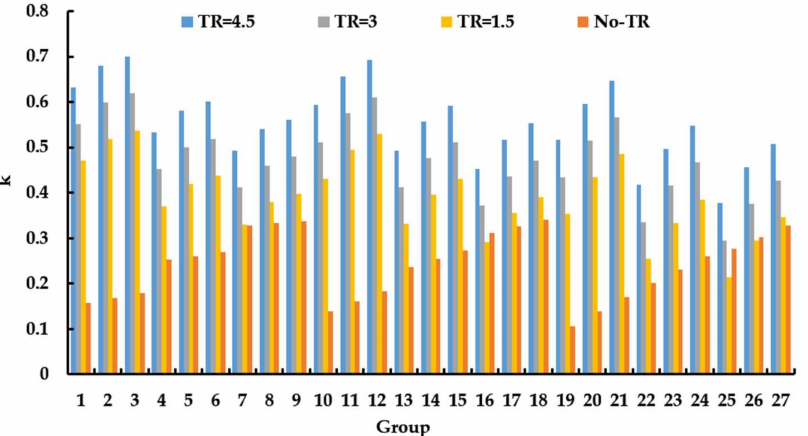
Figure 4. Comparison of the coefficient k of the two models.